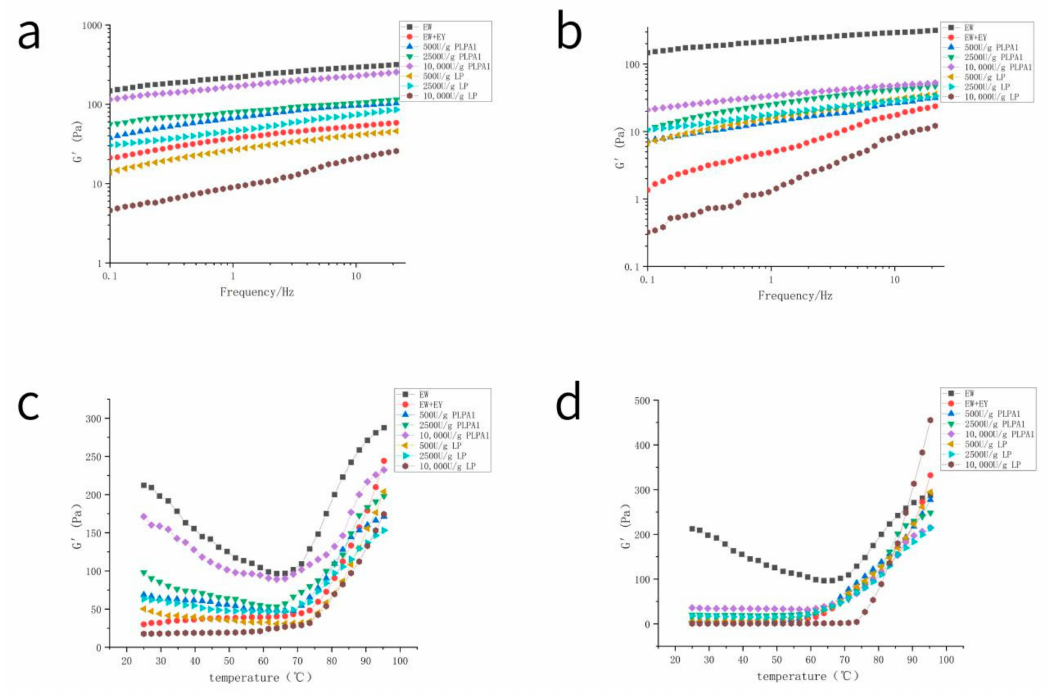
Figure 4. Rheological properties of fresh cake stick. The frequency scanning of fresh cake stick made by PLPA1 or LP hydrolysis of EW contaminated by 0.5 wt% EY ( a ) and 1 wt% EY ( b ); Storage modulus G (cid:48) development from 25 ◦ C to 95 ◦ C of EW contaminated by 0.5 wt% EY ( c ) and 1 wt% EY ( d